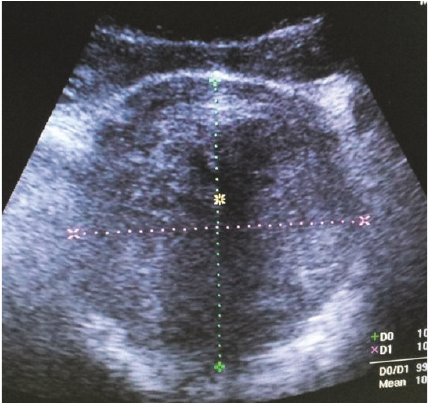
Figure 1: Abdominopelvic ultrasound study showing a well-defined uterine mass measuring 10,5cm × 10,6cm.